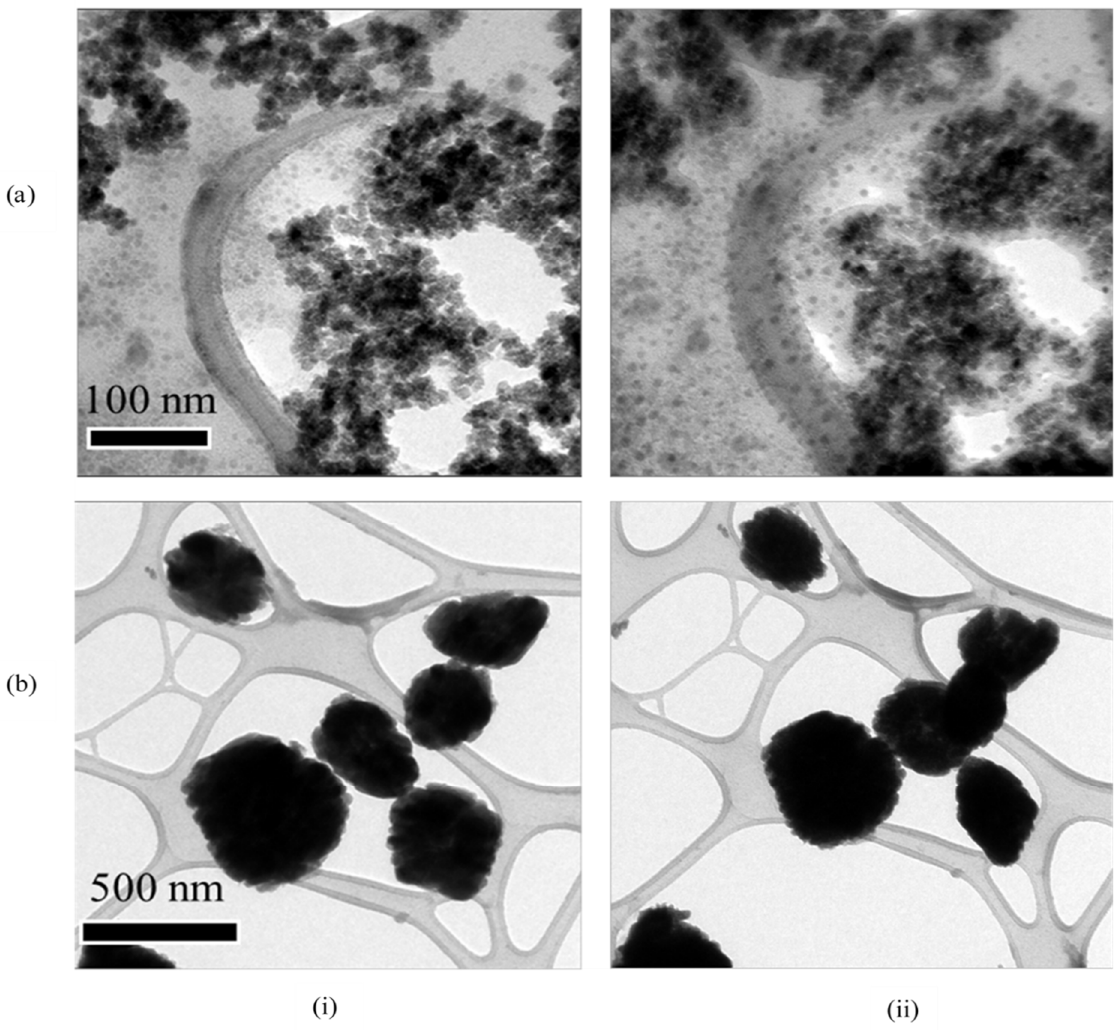
Figure 6. TEM images of nanoparticles generated from HMTA preparation route during thermal annealing: ( i ) 25 ◦ C and ( ii ) 500 ◦ C where ( a ) CeO x (scale bar = 100 nm) and ( b ) Eu:CeO x (scale bar = 500 nm).